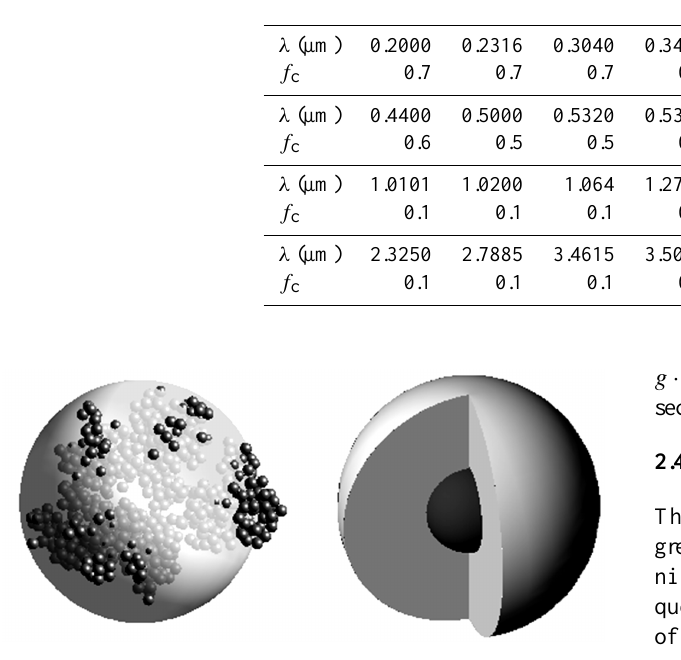
Figure 3. Morphologically realistic encapsulated aggregate model for internally mixed black carbon (left), and core-grey-shell model